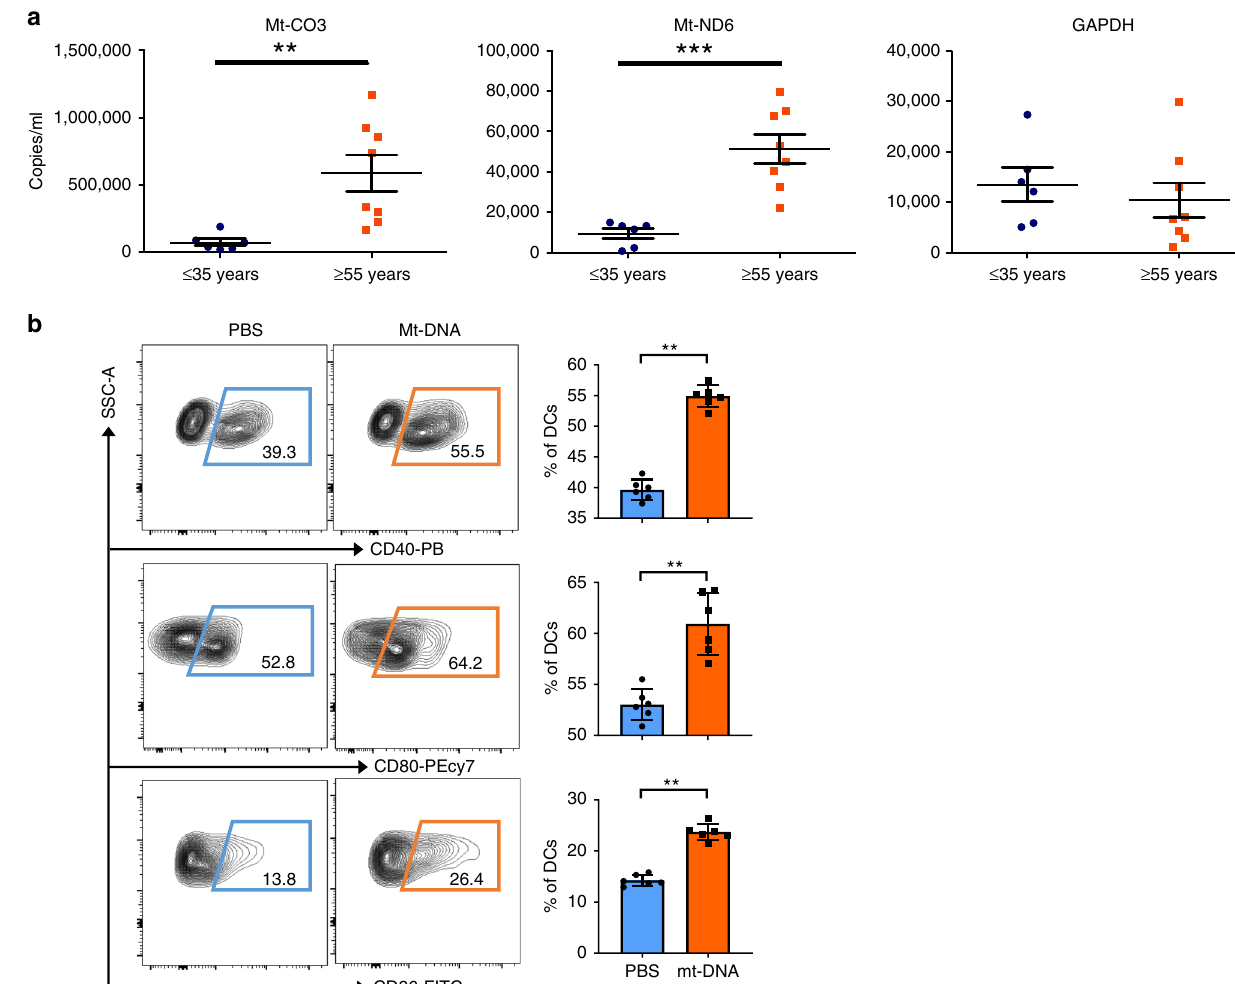
Fig. 5 Old human organ donors had increased systemic levels of cf-mt-DNA activating DCs. a Cf-mt-DNA was quanti fi ed in the plasma of young (<35 years) and old (>55 years) organ donors by RT-PCR using TAQMAN primers for mt-Co3 ( p = 0.0013) and mt-nd6 ( p = 0.0007), Scatter plots display mean ± SEM. b Dendritic cells were differentiated from isolated PBMC, stimulated with human mt-DNA (10 μ g/ml), and costimulatory molecule expression was analyzed using fl ow cytometry ( p = 0.0022). Column plots display mean ± SD ( n = 6 biologically independent samples); results are representative of at least three independent experiments. Statistical signi fi cance was determined by using two-tailed Mann – Whitney-test. Asterisks indicate p values * p ≤ 0.05, ** p ≤ 0.01, and *** p ≤ 0.001, only signi fi cant values are shown. Source data are provided as a Source Data fi